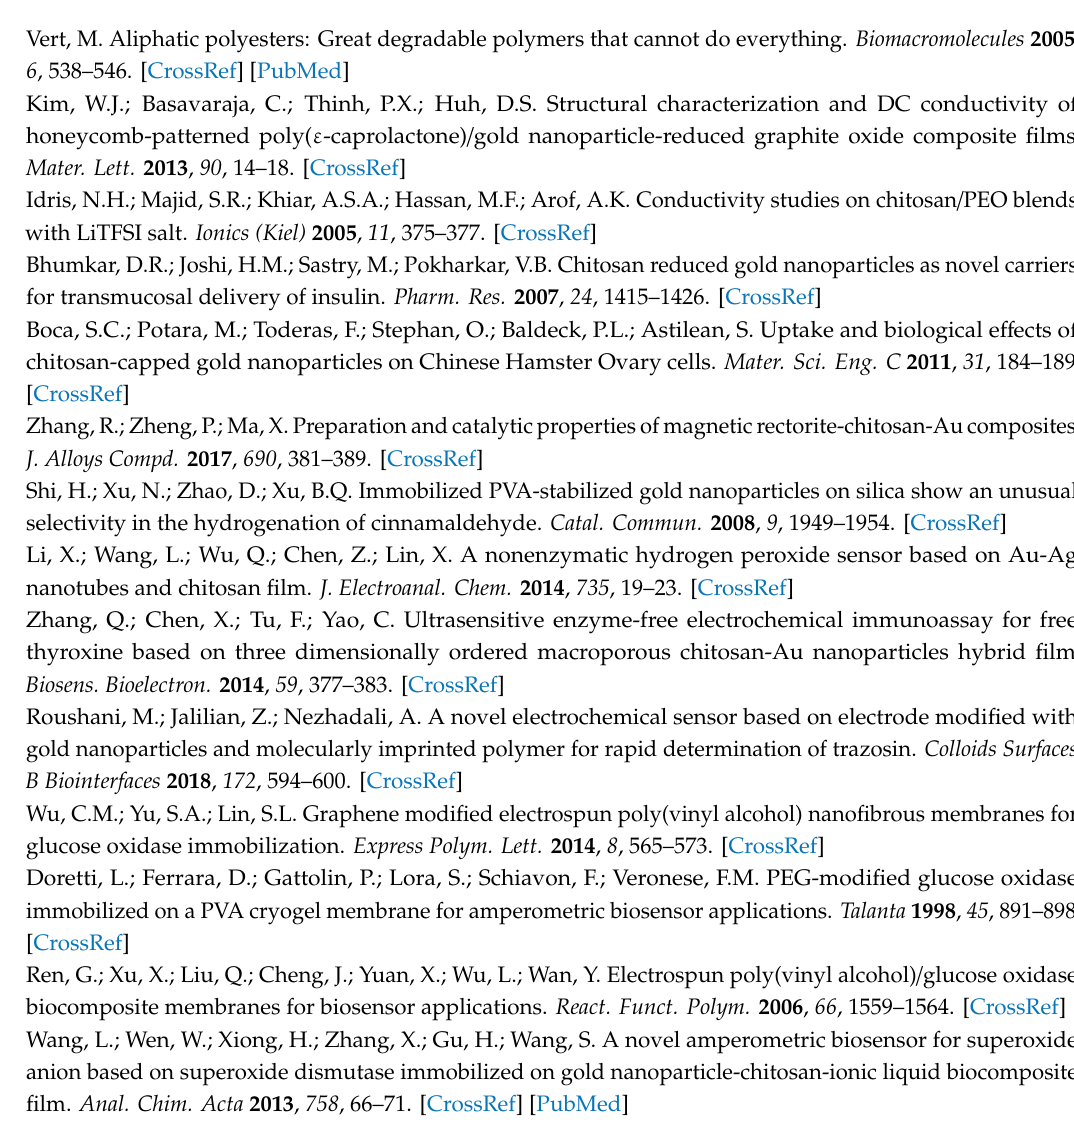
Table S1. Equations for the calculate of Dn , Dz and PDI , from distributions of particle size by Dynamic Light Scattering (DLS), Figure S1. Photographs obtained by TEM of chitosan-AuNPs nanostructures collapsed on the copper grid for the concentration of 0.4mM HAuCl 4 · 3H 2 O, Figure S2. Eg calculations of 0.4 mM HAuCl 4 · 3H 2 O concentration, and di ff erent SWCNT-COOH concentrations: 0.1, 0.3 and, 0.5 wt.%, Figure S3. Eg calculations of 0.7 mM HAuCl 4 · 3H 2 O concentration, and di ff erent SWCNT-COOH concentrations: 0.1, 0.3 and, 0.5 wt.%, Figure S4. Eg calculations of 1.0 mM HAuCl 4 · 3H 2 O concentration, and di ff erent SWCNT-COOH concentrations: 0.1, 0.3 and, 0.5 wt.%, Figures S5. Eg calculations of 1.3 mM HAuCl 4 · 3H 2 O concentration, and di ff erent SWCNT-COOH concentrations: 0.1, 0.3 and, 0.5